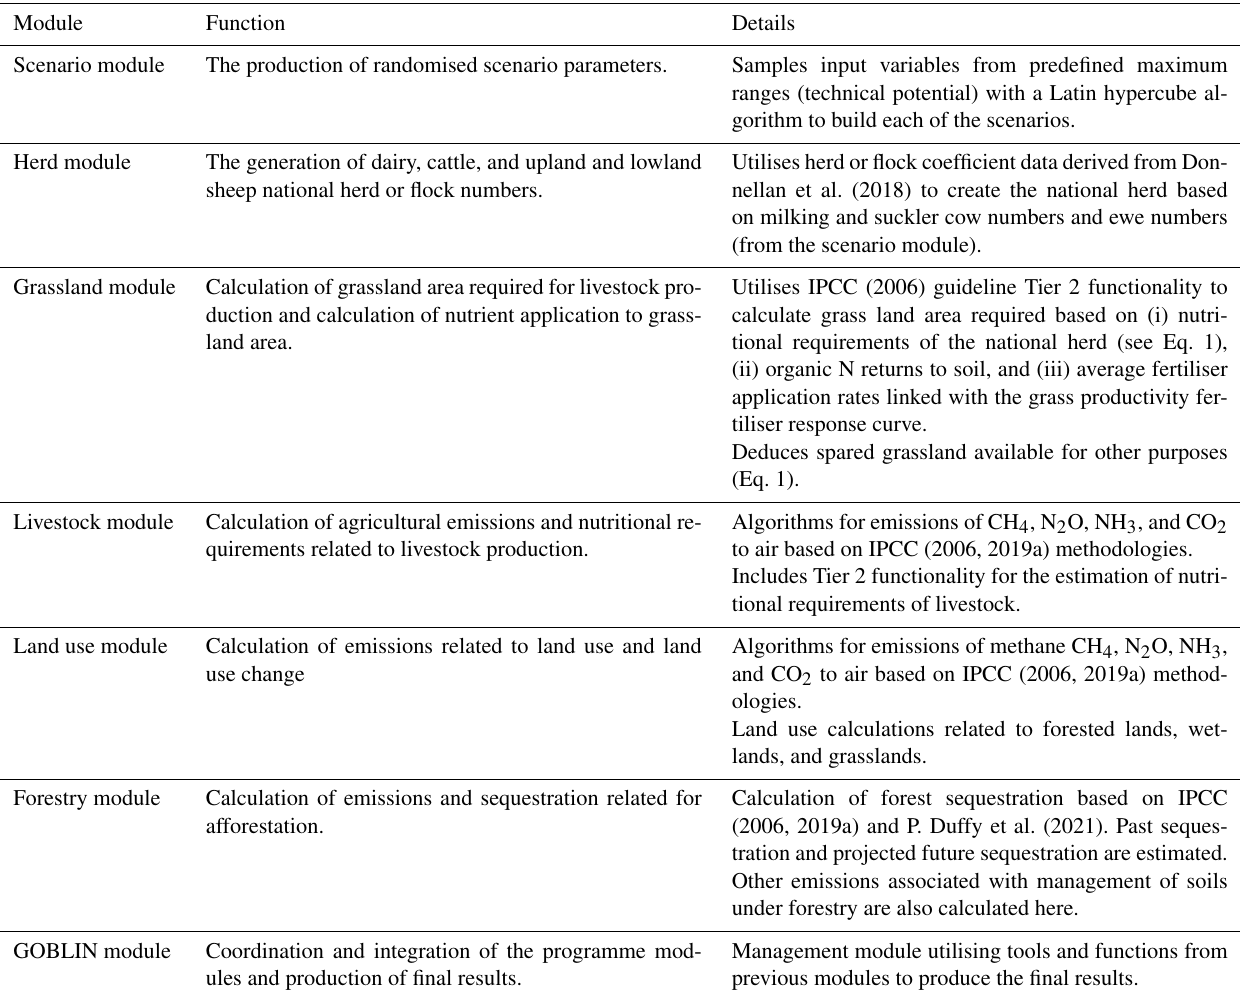
Table 1. Summary of module functions within